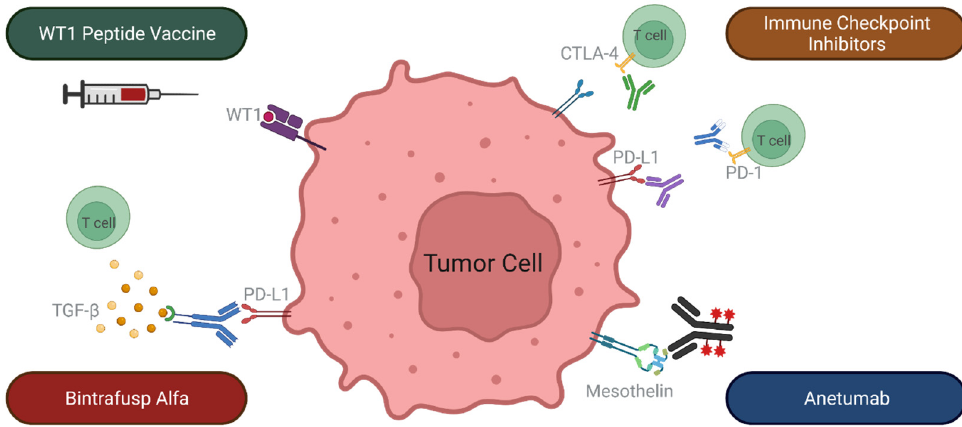
Figure 2. Immunotherapeutic interventions that are under investigation for treatment of recurrent thymic epithelial tumors. CTLA-4: cytotoxic T lymphocyte-associated antigen 4; PD-1: programed death-1; PD-L1: programed death-ligand 1; TGF- β : Transforming growth factor β .